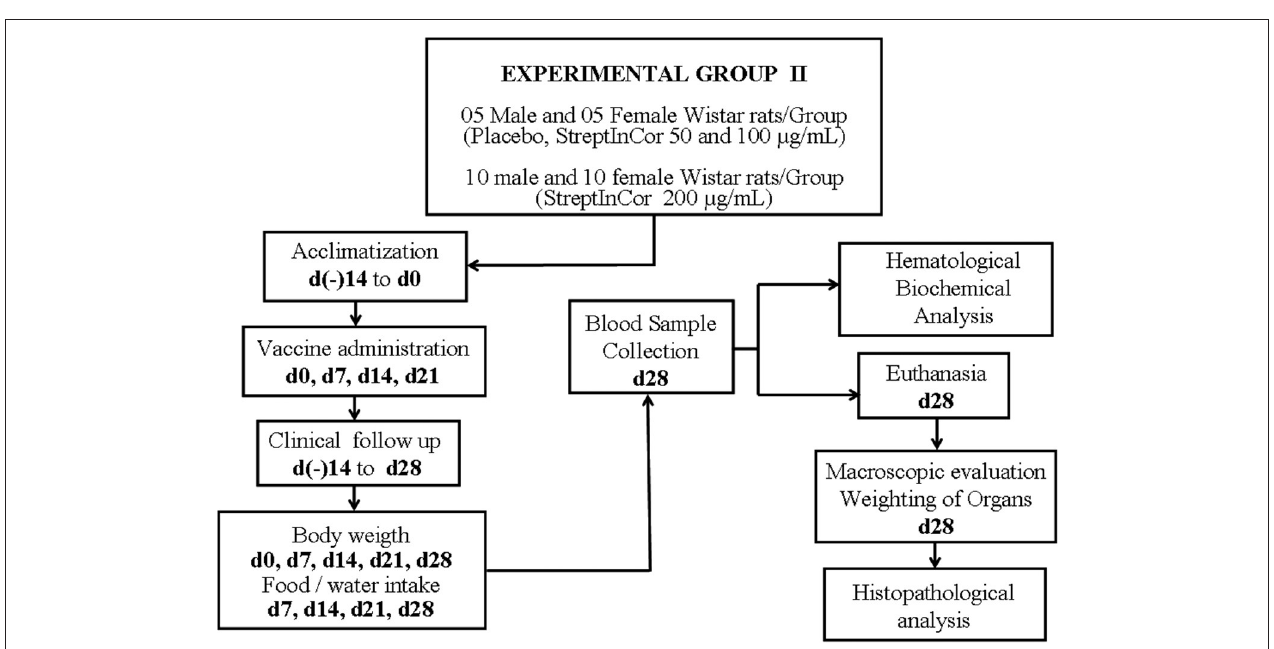
FIGURE 1 | Experimental design.